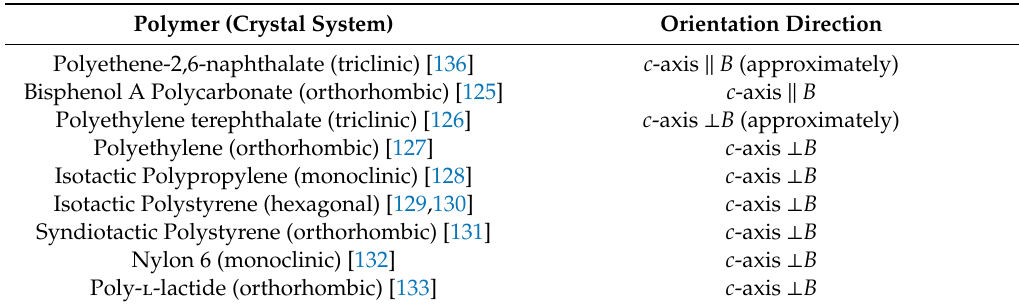
Table 2. List of magnetically aligned crystalline polymers during melt crystallization. Orientation direction shows the relationship with a static magnetic